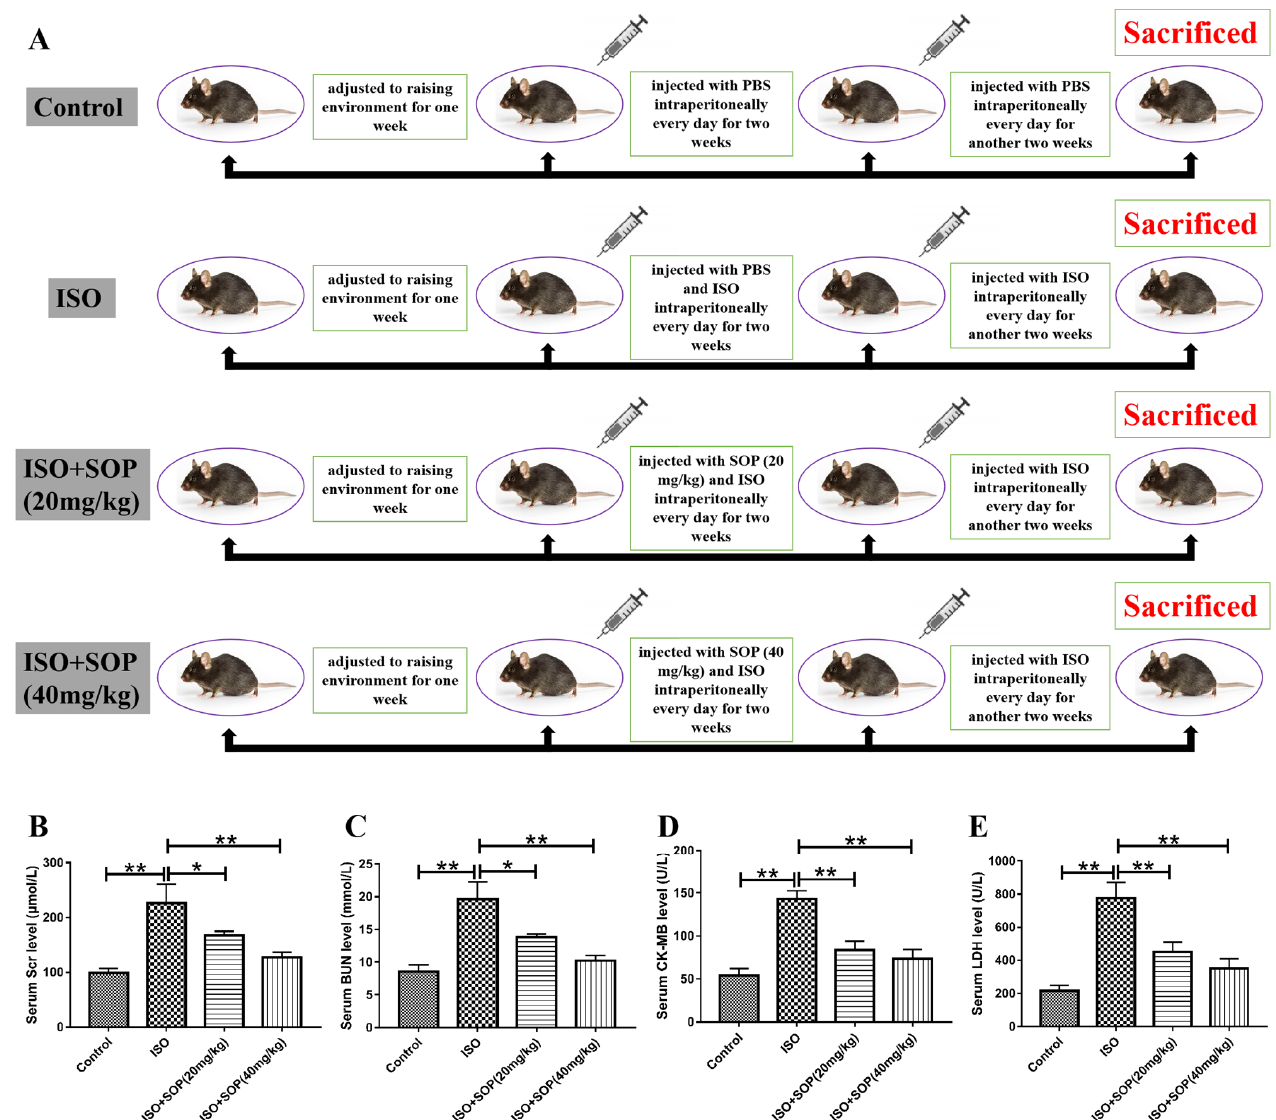
Figure 1. ( A ) Overview of animal treatment protocols applied in the present study. ( B , C ) Serum levels of serum creatinine (SCr) and blood urea nitrogen (BUN) were detected (n = 7–8). ( D , E ) The cardiac injury biomarkers CK-MB and LDH were also investigated (n = 7–8). * p < 0.05 and ** p < 0.01. Data represent the mean ± SD of at least three separate experiments.